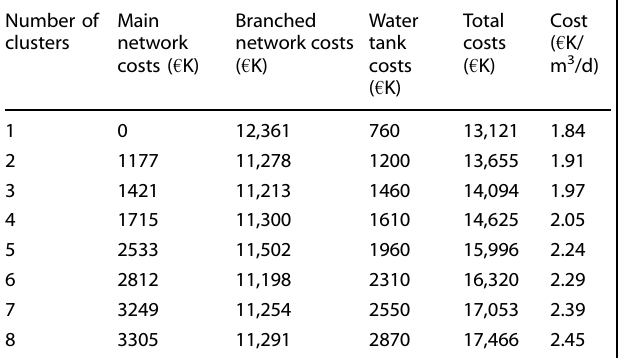
Table 3. Reclaimed water network construction costs for different clustering solutions, both public and private uses